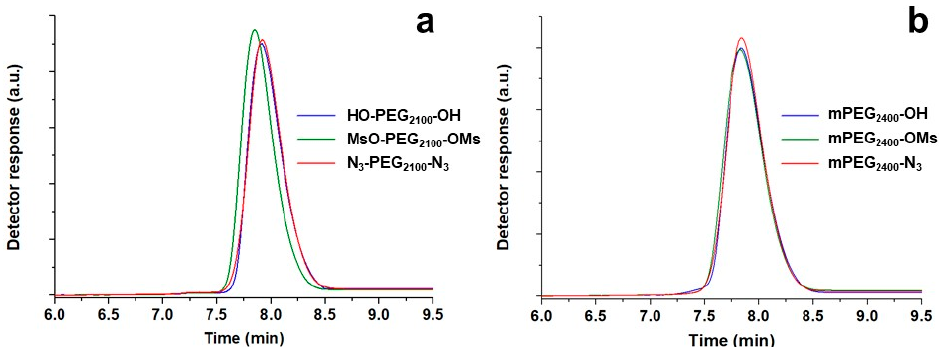
Figure 3. Normalized SEC curves of mPEG 2000 ( a ) and PEG 2400 ( b ) series.